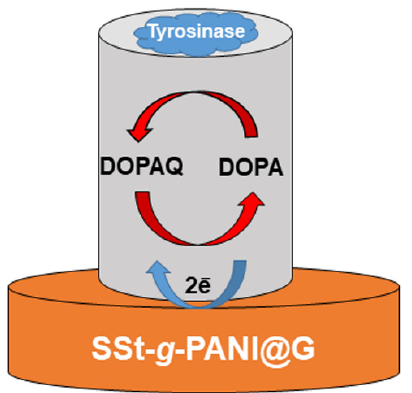
Figure 8. The principle of detecting L-dopa by using a SSt- g